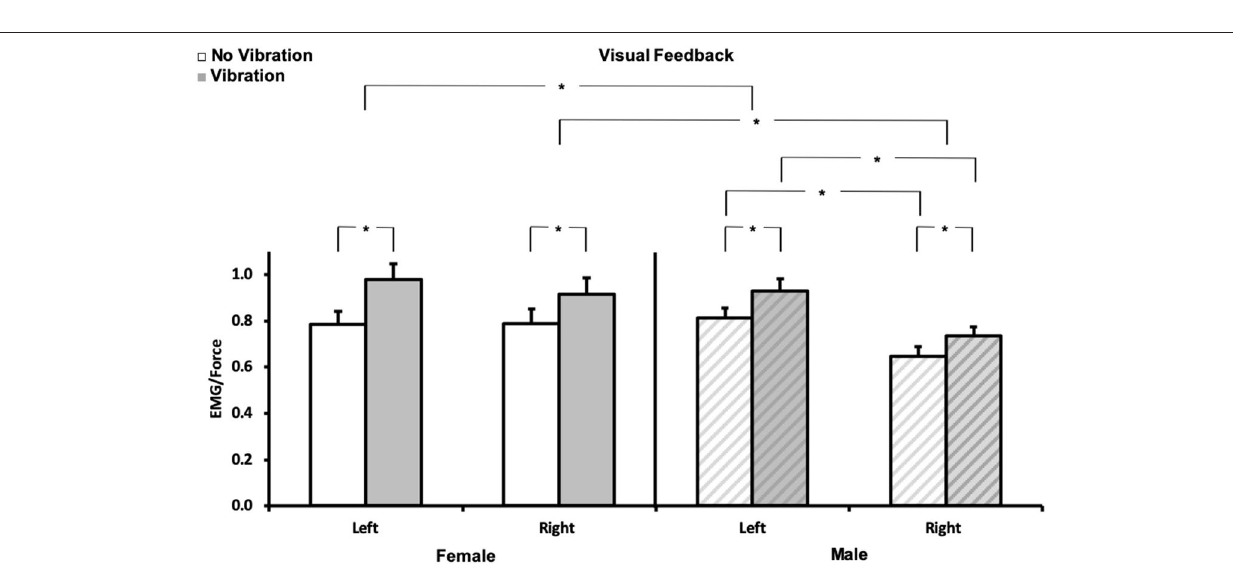
a combination of muscle action potentials, decoding